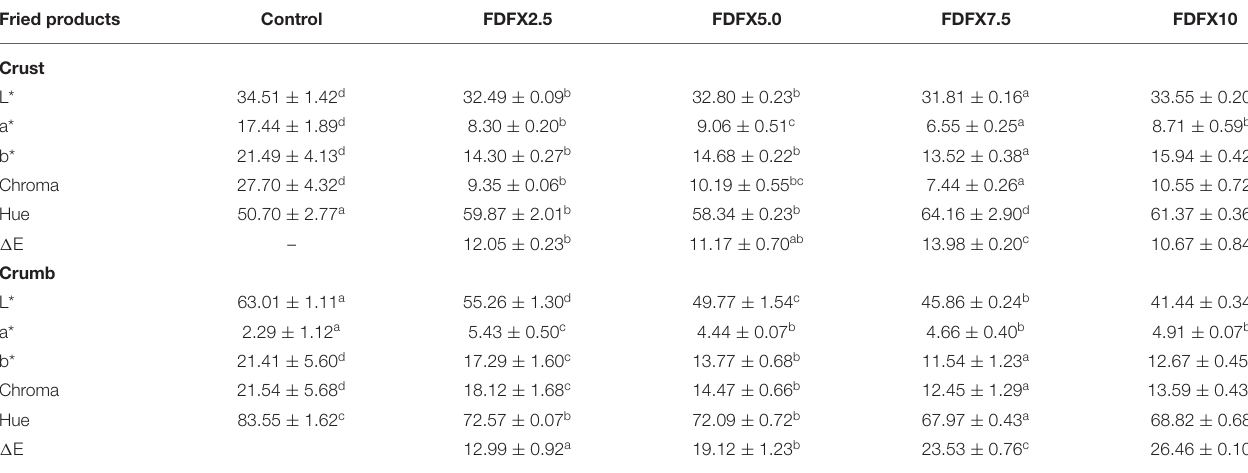
TABLE 3 | Color profile of flaxseed-enriched fried dough. Fried products